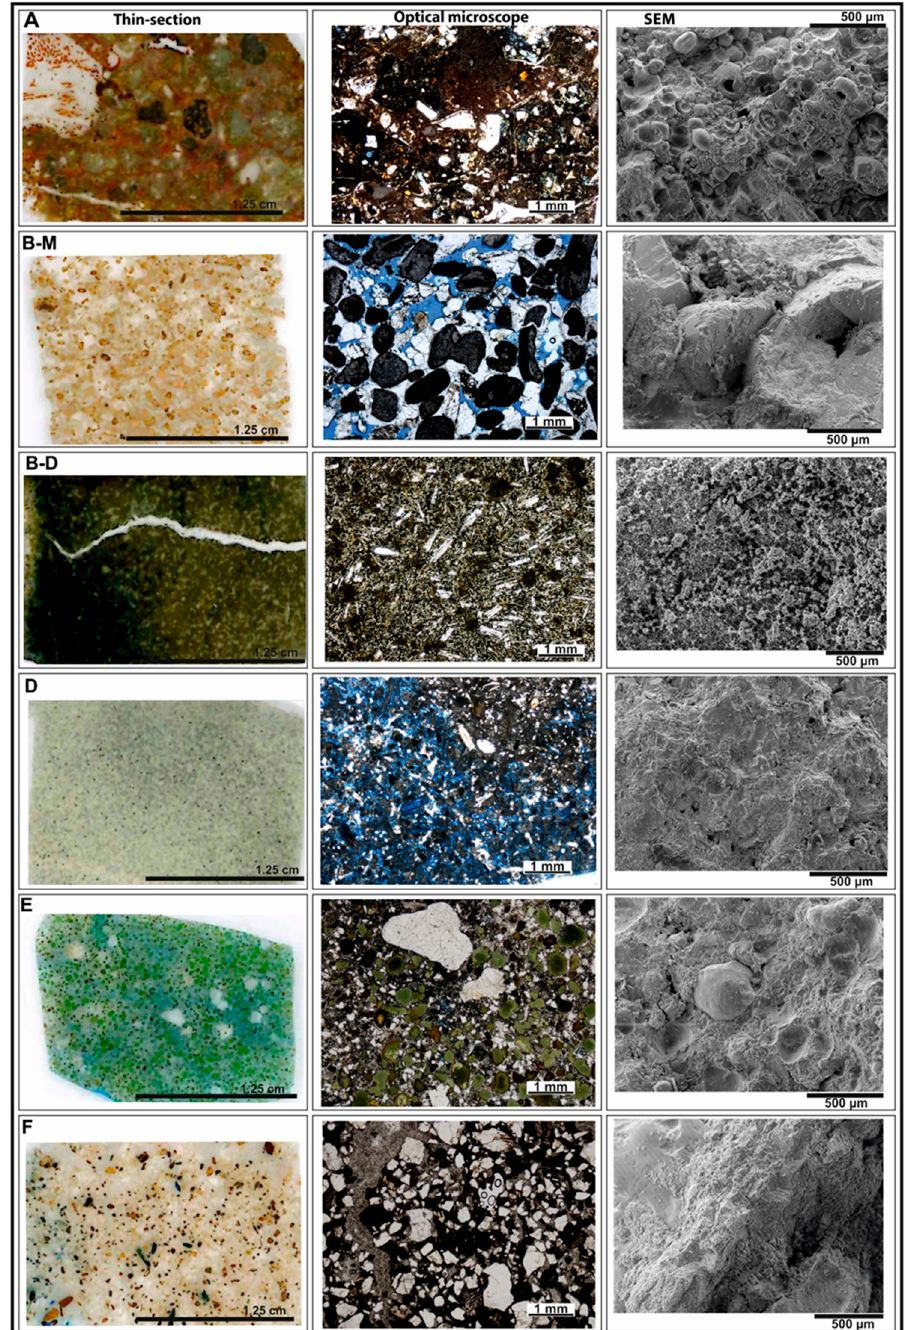
Figure 3. Thin-section scans, petrographic optical microscope and SEM images for all studied core plugs.